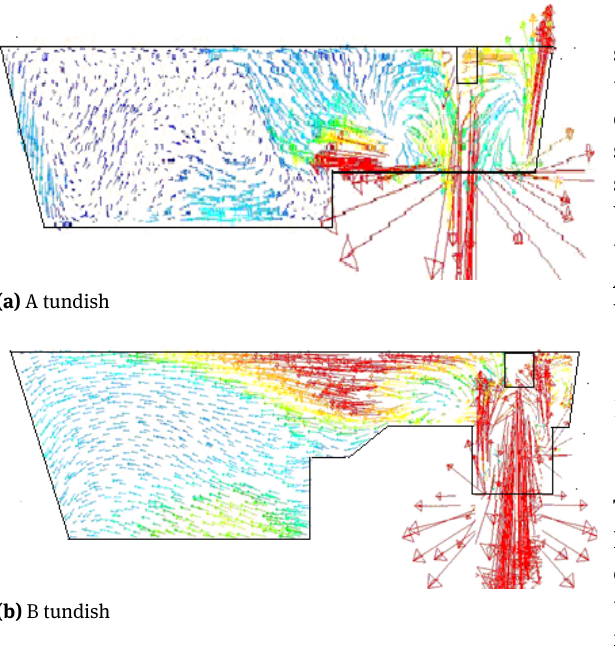
Figure 5: Velocity vectors in tundish.